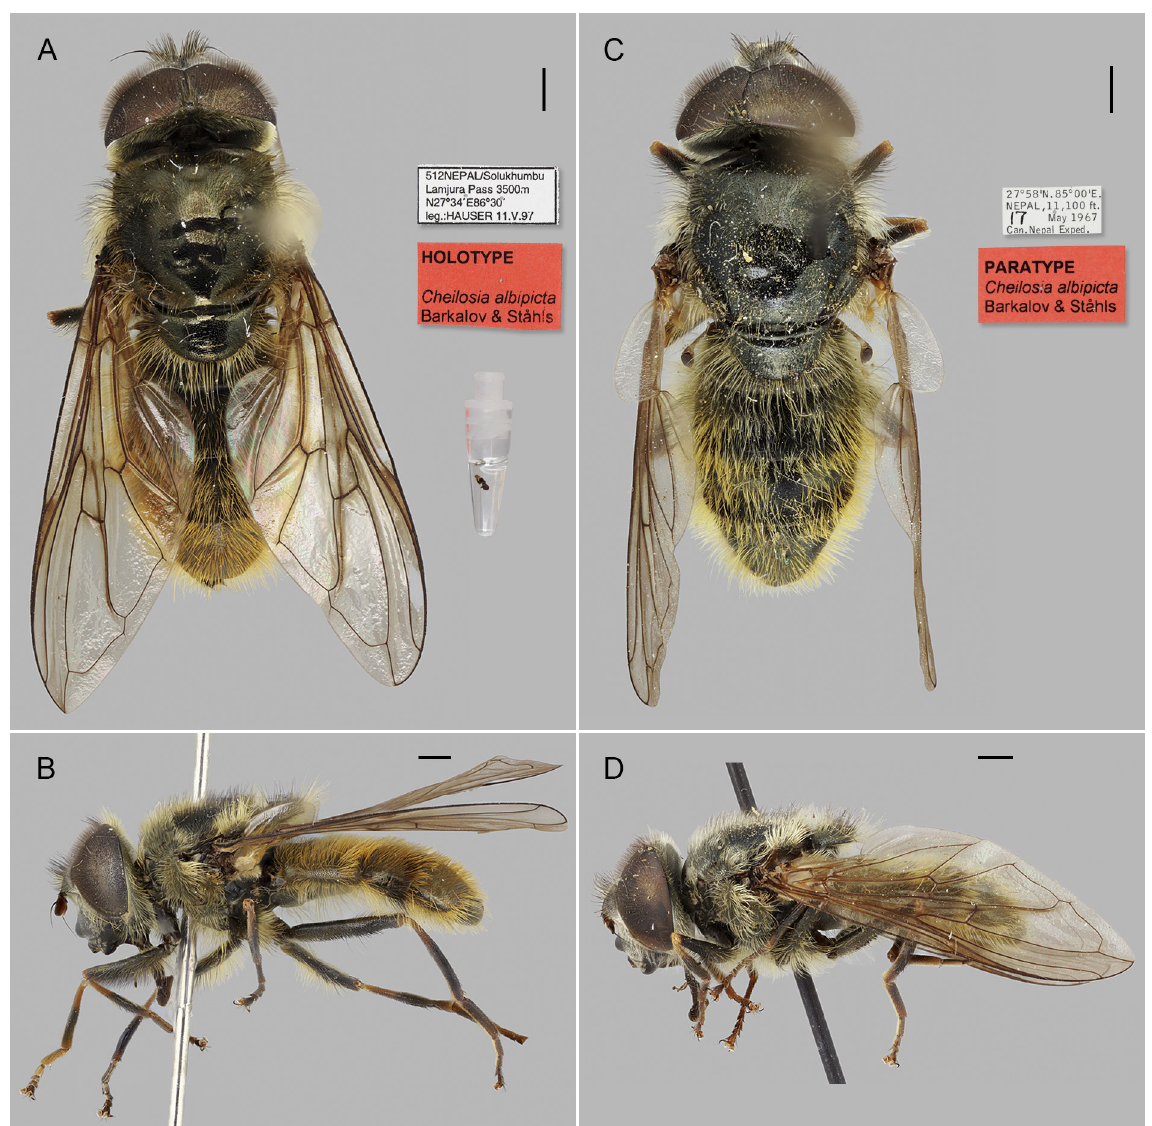
Fig. 4. Cheilosia ( Montanocheila ) albipicta sp. nov. A–B . Holotype, ♂ (CSCA); dorsal and lateral views. C–D . Paratype, ♂ (CNC); dorsal and lateral views. Photo: Pekka Malinen, FMNH Luomus. Scale bars = 1